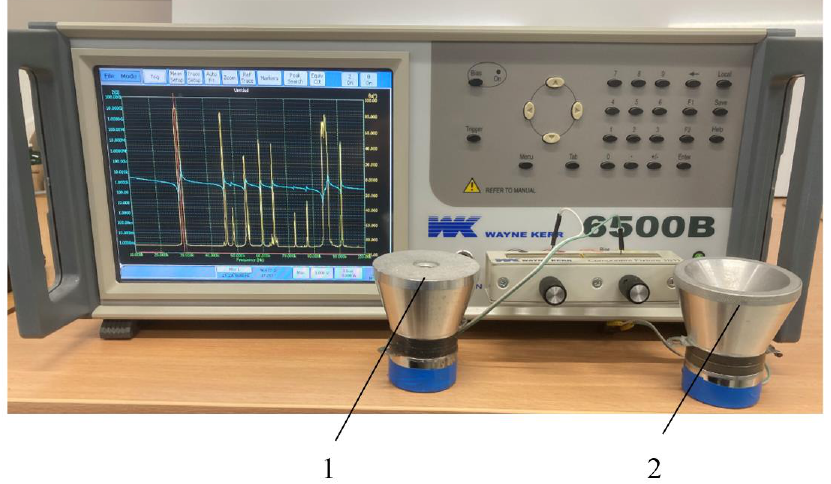
Figure 3. Experimental setup with impedance analyzer 6500 B (Wayne Kerr Electronics Ltd., Bognor